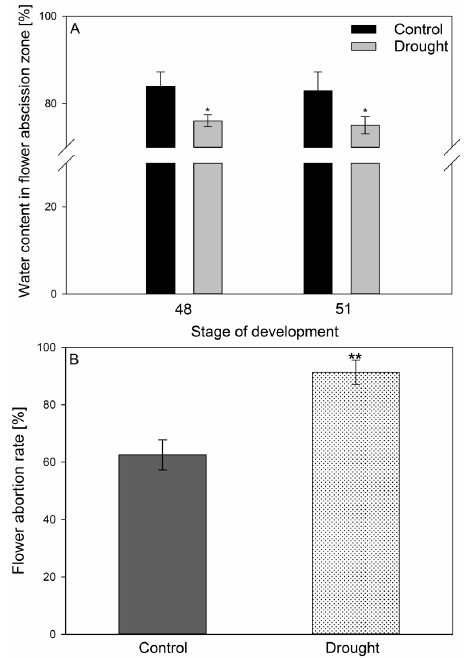
Figure 1. The influence of soil drought stress on the water content in flower abscission zone (AZ) [%] ( A ) and flower abortion rate (%) ( B ) in Lupinus luteus . Control plants were growing in soil of optimal moisture (70% holding capacity; WHC). In parallel, part of plants was subjected to drought conditions for 2 weeks (25% WHC). Plant material for water content measurements was collected on the 48th and 51st days of cultivation ( A ). The number of aborted flowers per one lupine was counted and the data were presented as averages of 15 technical replicates ± SE. Significant differences to stress plants in comparison to control are indicated as * p < 0,05, ** p < 0.01 (Student’s t- test).